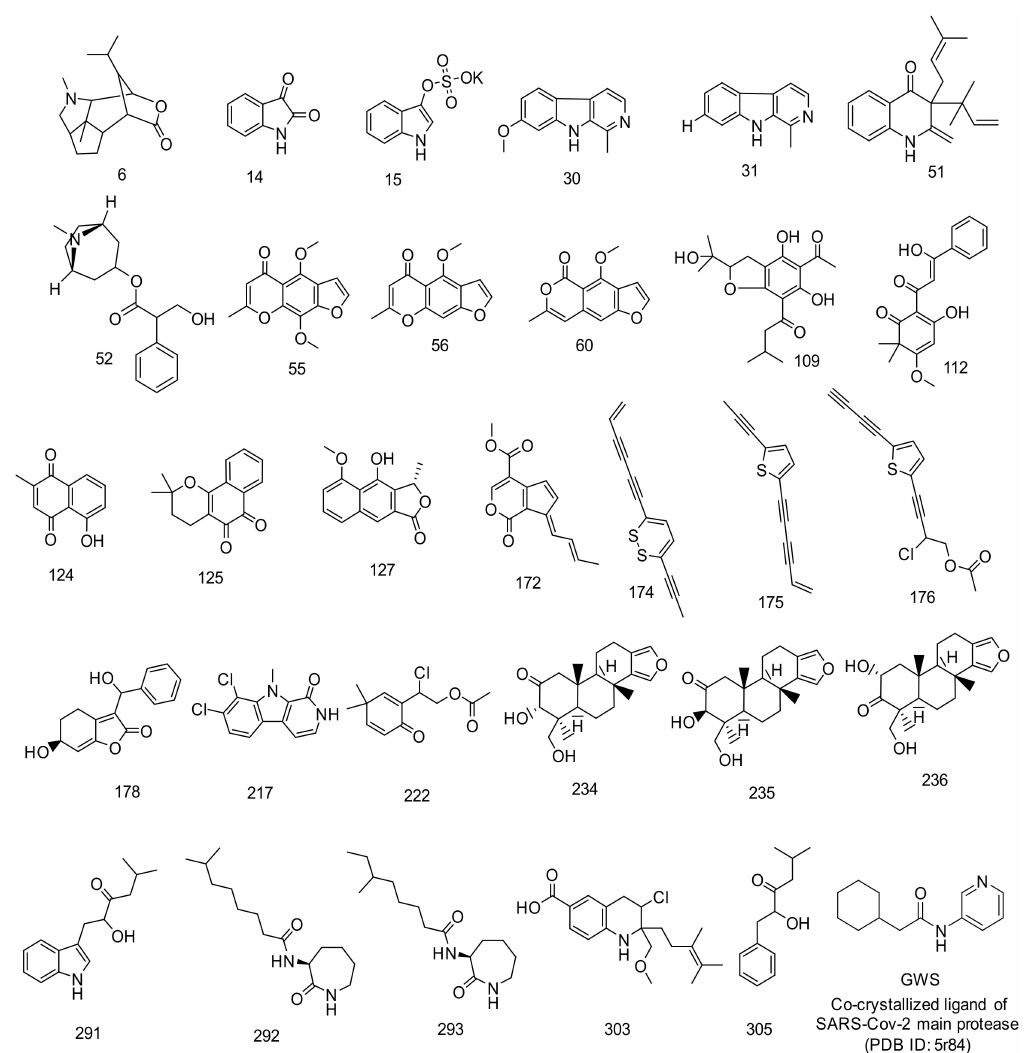
Figure 2. Metabolites with molecular similarity with GWS